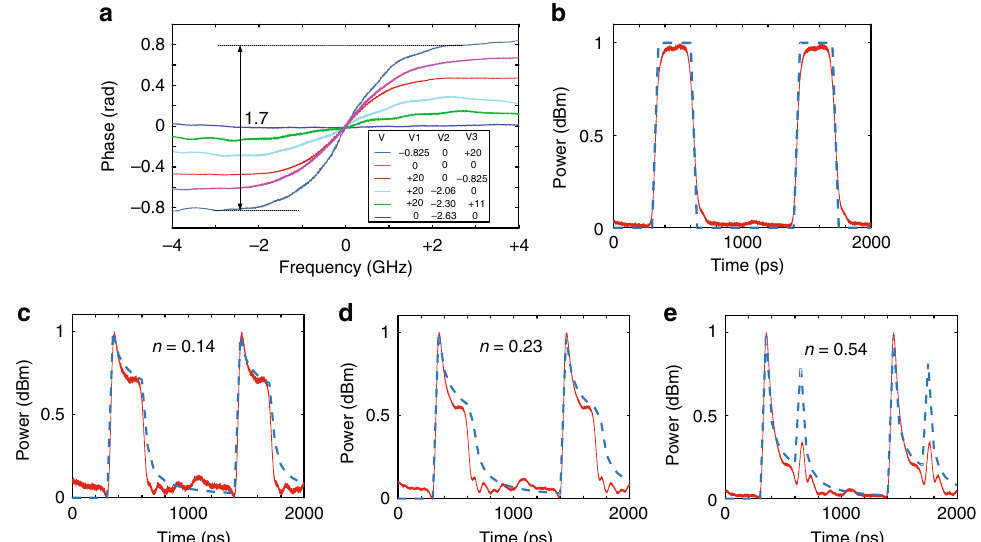
Fig. 5 Experimental result of temporal differentiation. a Tunable phase jump of the recon fi gurable grating. b Generated in red and simulated in blue rectangular pulse train. c – e The differentiated rectangular pulse with a fraction order of 0.14, 0.23, and